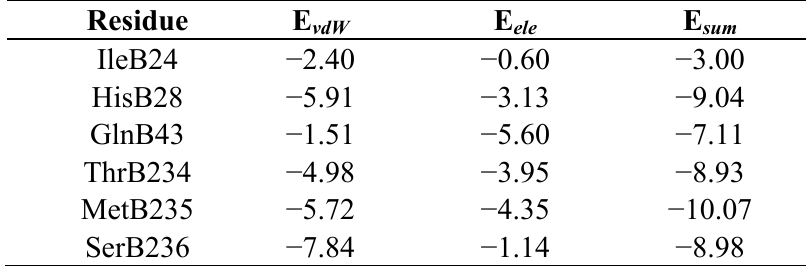
Table 3. The vdW, electrostatic and sum interaction energies (E involving chamaejasmine with the key residues of tubulin protein a